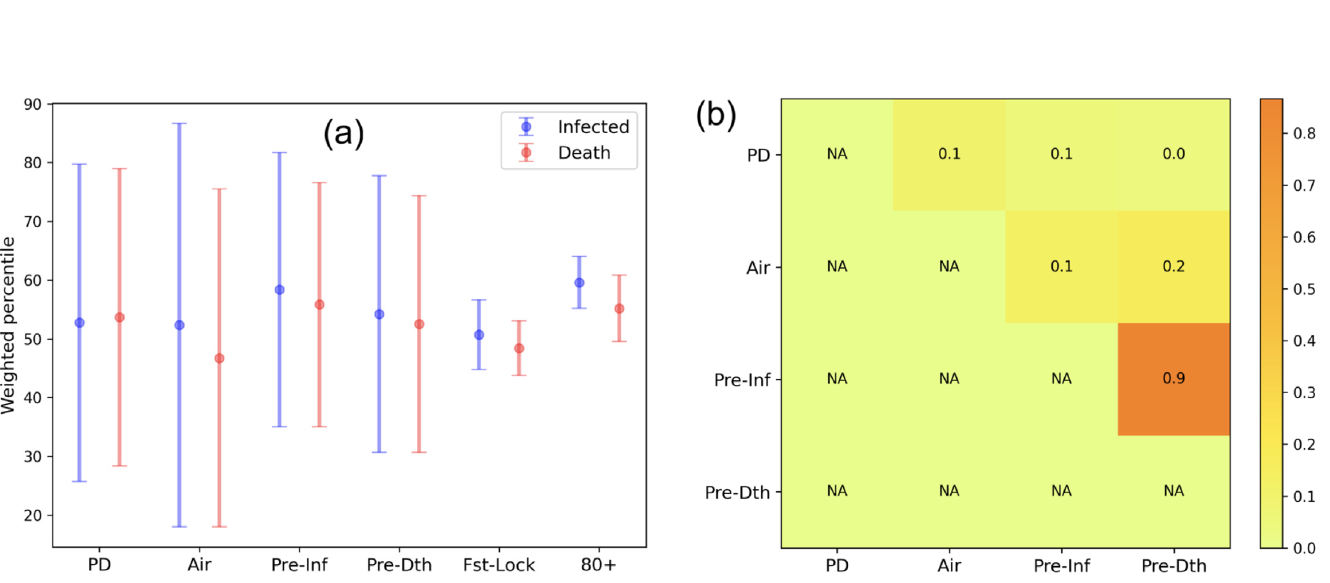
Fig 6. Identification of discriminating features: (a) maximum difference in weighted average percentile for top and bottom k COVID-19 affected US; (b) heatmap showing the pairwise Pearson correlation correlation between discriminating features.